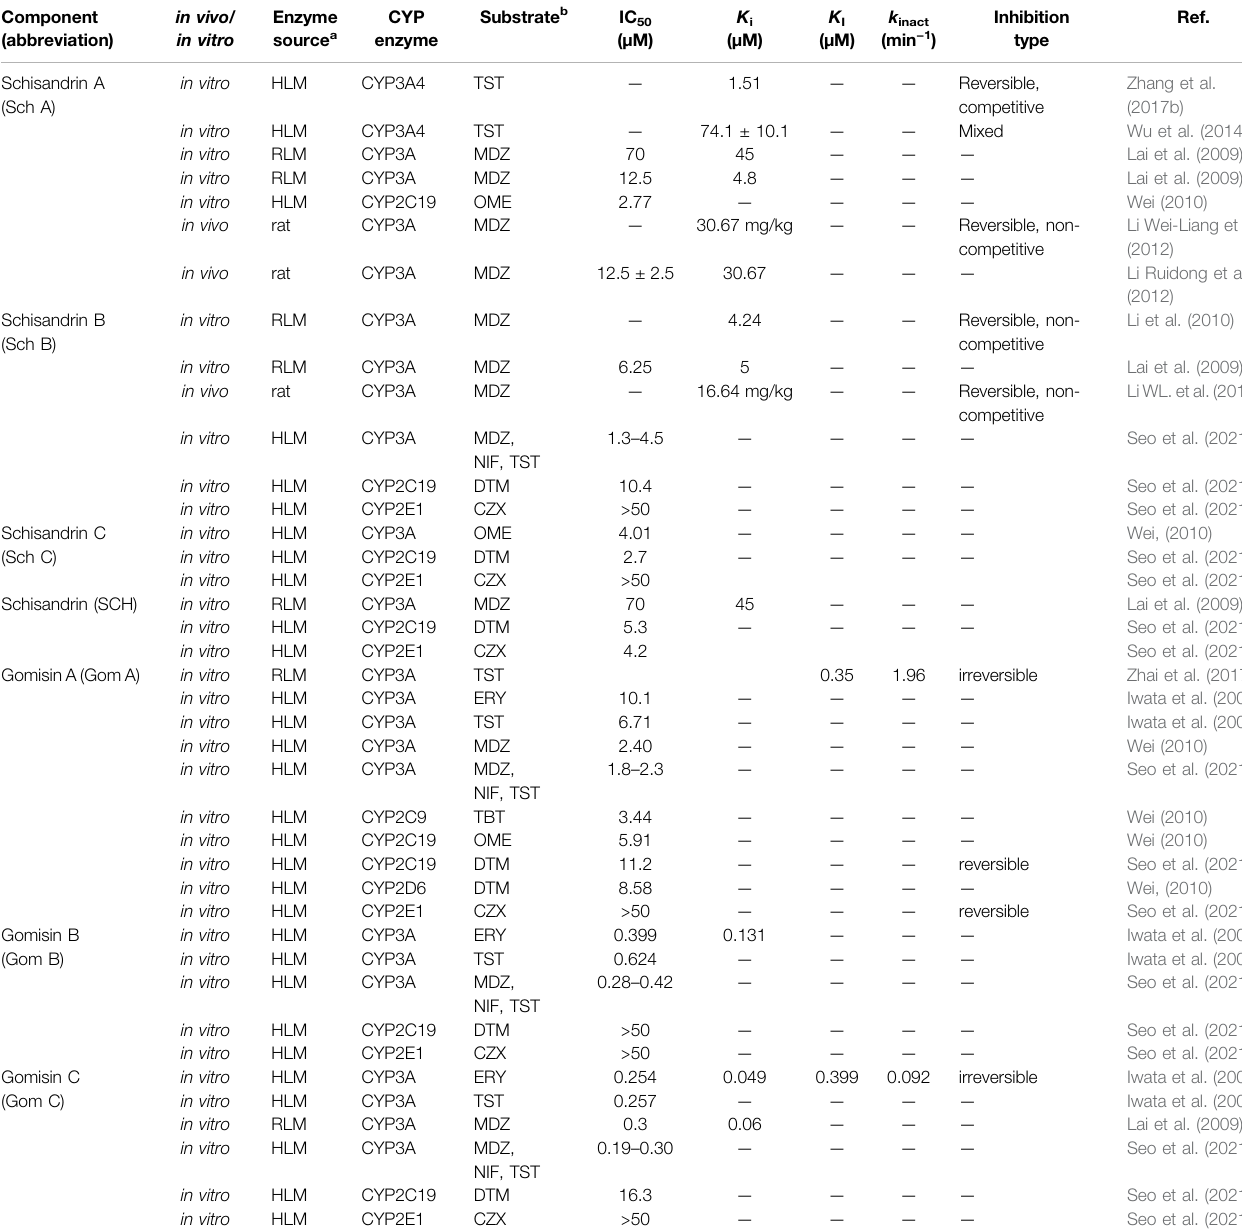
TABLE 3 | Inhibitory of main CYP450 isoform activity by the major schisandra lignans. Component